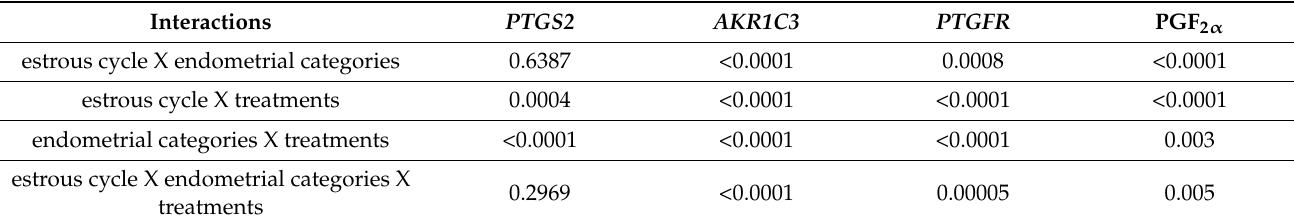
Table 2. Two- and three-way interactions and significance levels ( p values) between estrous cycle phases, endometrial category groups, and treatments for relative mRNA levels of PGF 2 α pathway target genes and PGF 2 α production by equine endometrial explants.